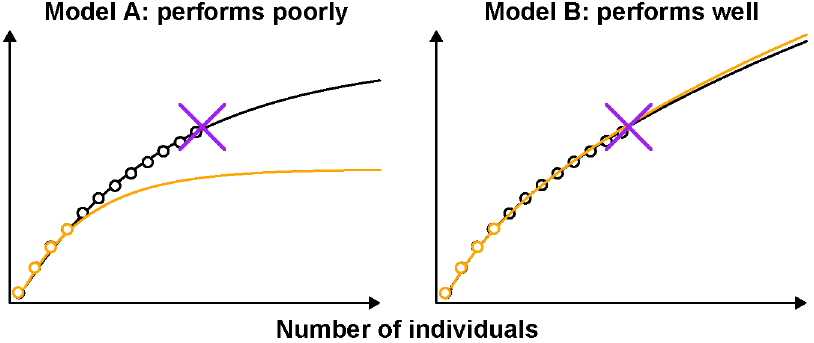
Figure 1. Outline of DivE species richness estimator. DivE fits many models to rarefaction curves (black) and subsamples thereof (orange). Data is denoted by circles; fits by solid lines. Models are scored according to the following criteria: i) Discrepancy – mean percentage error between data points and model prediction; ii) Accuracy – error between full sample species richness (purple cross) and estimated species richness from subsample; iii) Similarity – area between subsample fit (orange) and full data fit (black); and iv) Plausibility – we require that S’(x) $ 0 and S"(x) # 0 . The best performing models are aggregated and extrapolated to estimate species richness. Model A performs poorly as criteria ii) and iii) are not satisfied. Model B performs well as all criteria are satisfied.